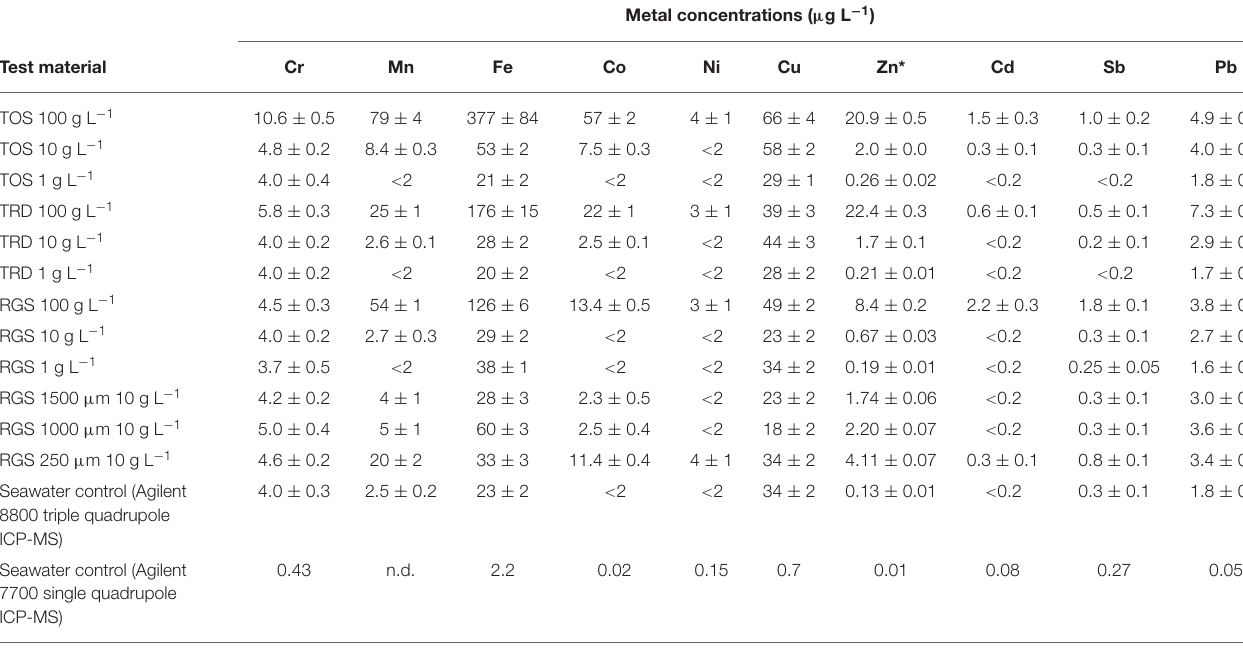
TABLE 6 | Content of target metals in seawater leachates as a function of CRG